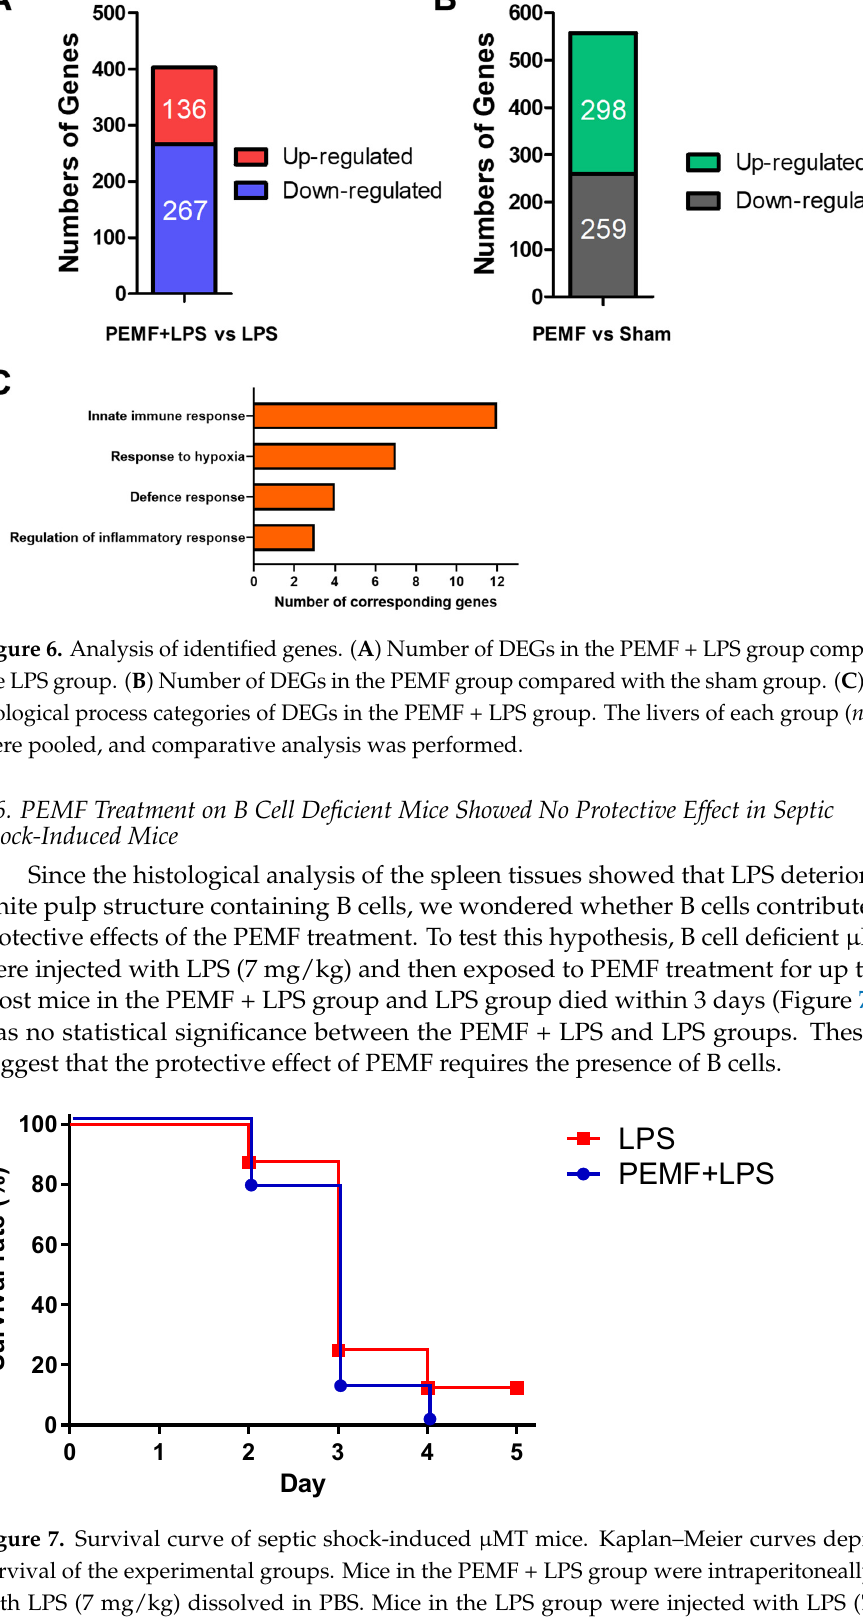
Table 1. Representative differentially expressed genes in the PEMF + LPS group versus the LPS group.